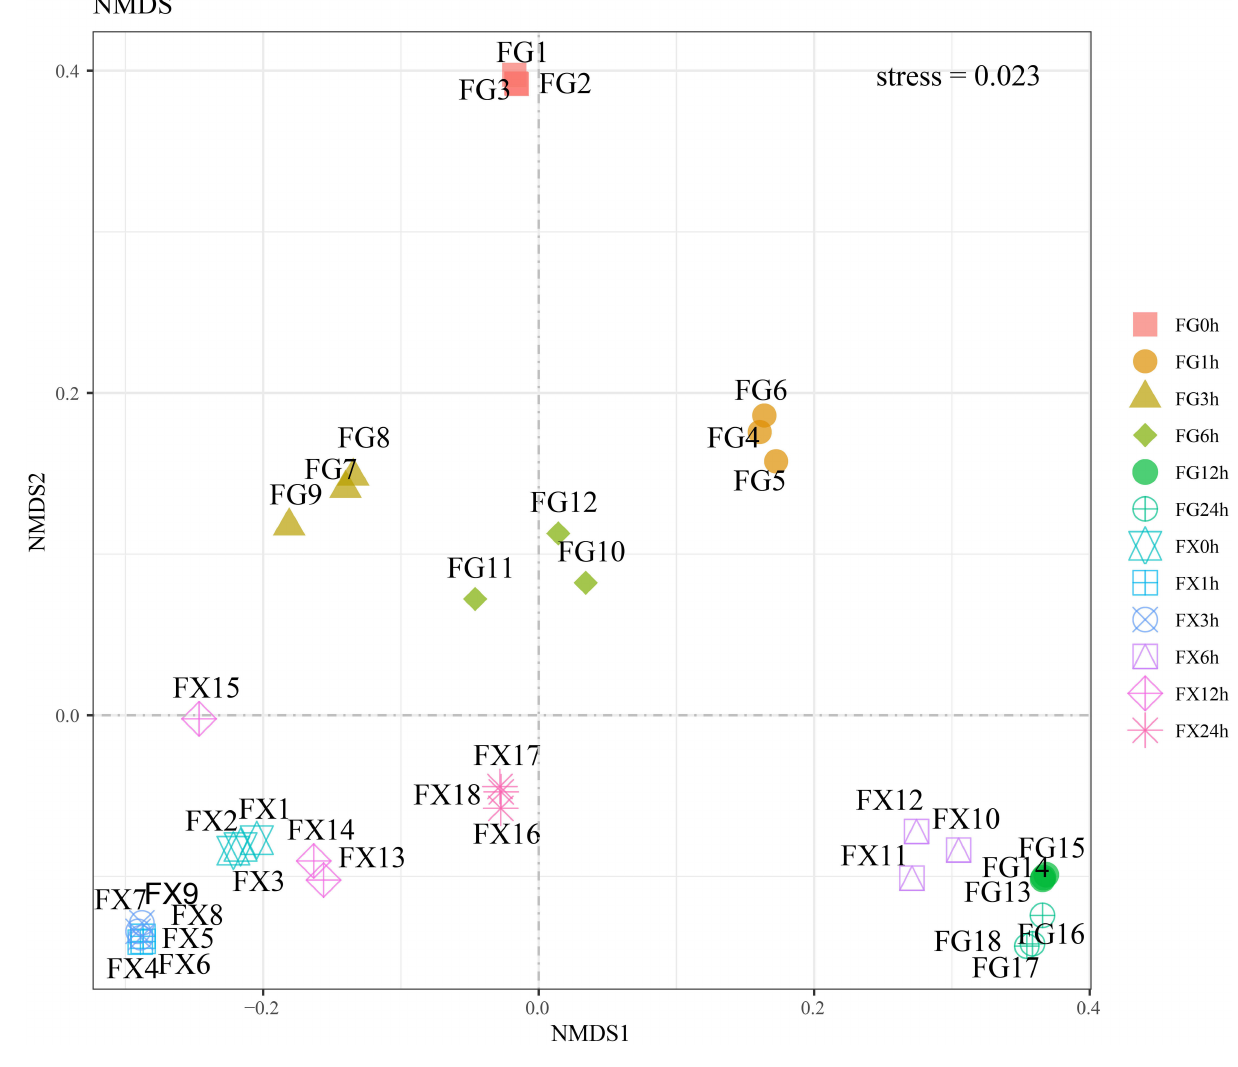
FIGURE 5 | The nonmetric multidimensional scaling (NMDS) of the plant hormone components for Z. bungeanum varieties FG and